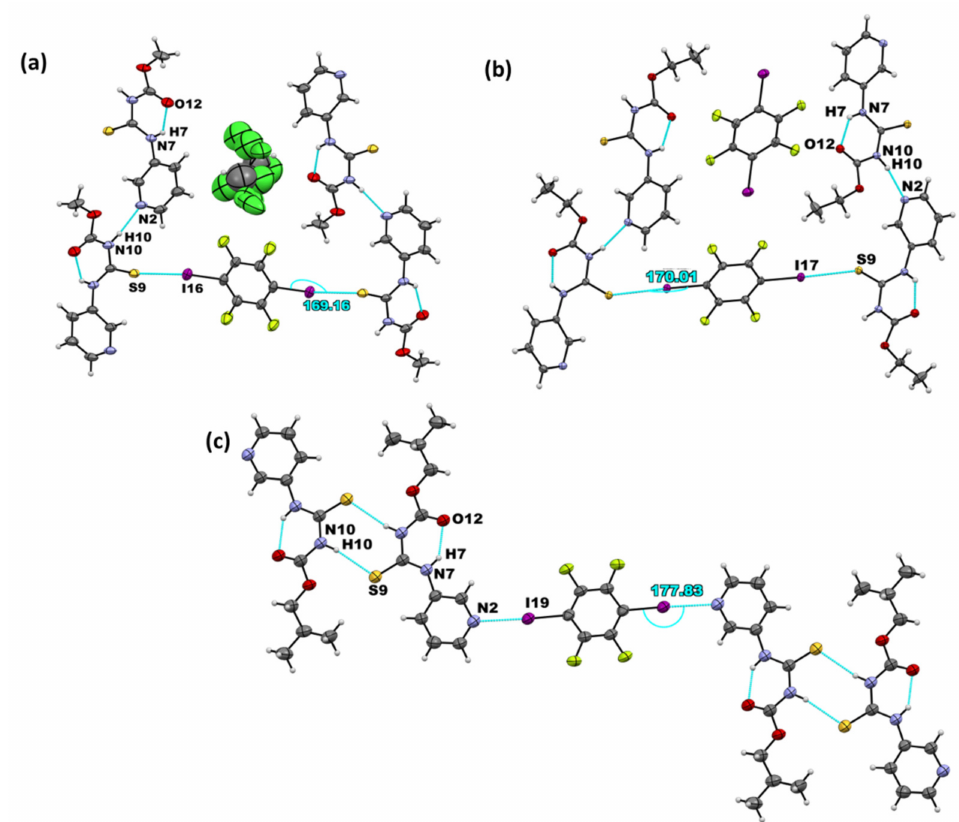
Figure 4. Primary non-covalent interactions (in blue) in the crystal structures of ( a ) (A1) 2 · D2 , ( b ) A2 · D2, and ( c ) (A3) 2 · D2